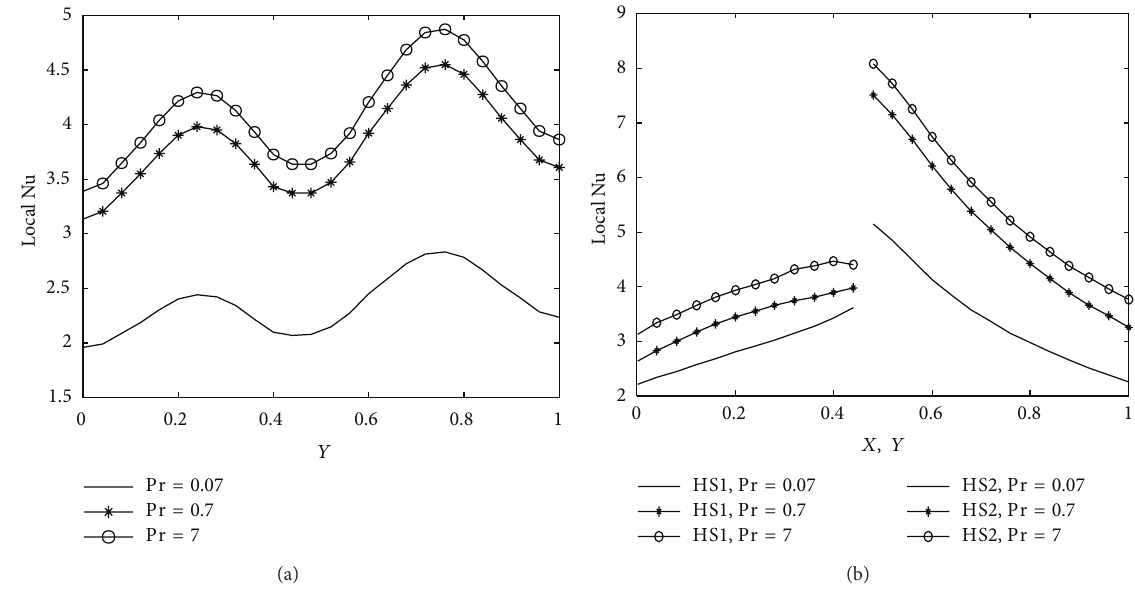
Figure 11: Variation of local nusselt number with Pr at Ra = 10 5 , 𝐴 = 0.2 , 𝑛 = 2 , ℎ𝑥 = 0.55 , and ℎ𝑦 = 0.55 (a) along cold wavy surface and (b) along the heaters.